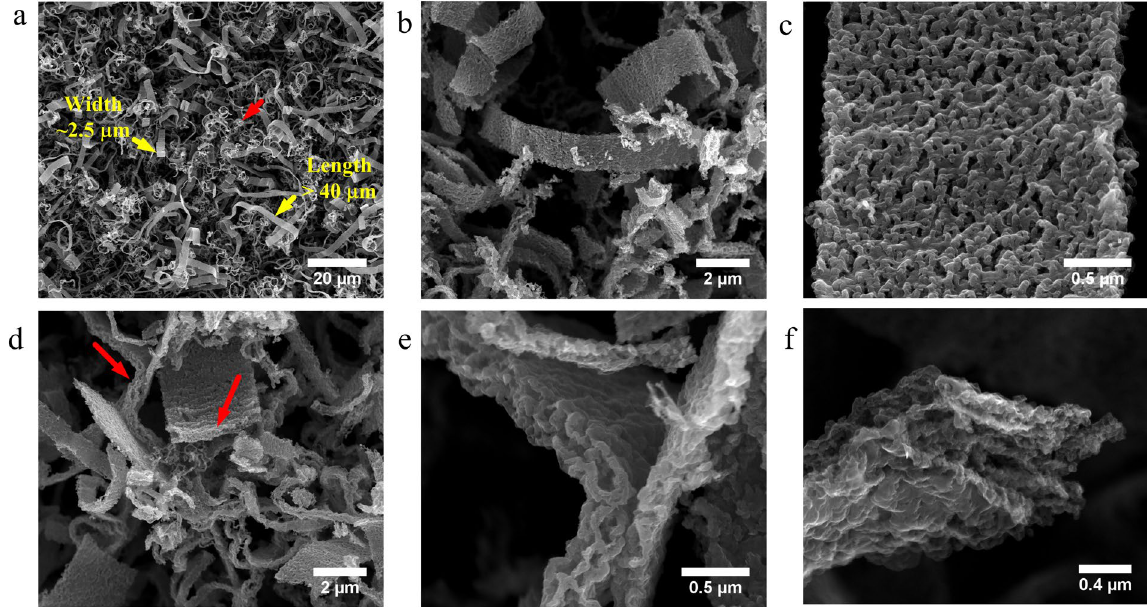
Figure 1. SEM images of the synthesized nitrogen-doped carbon belt (N-CB) structures. ( a ) Low magnification image showing the synthesized sample. ( b ) N-CB of ~2 μ m width and 5–20 μ m length. ( c ) Magnified image showing the N-CB. ( d ) Front view of N-CBs showing the side and front views (see the arrows). ( e ) Cross section view of a N-CB, and ( f ) the tip structure of a